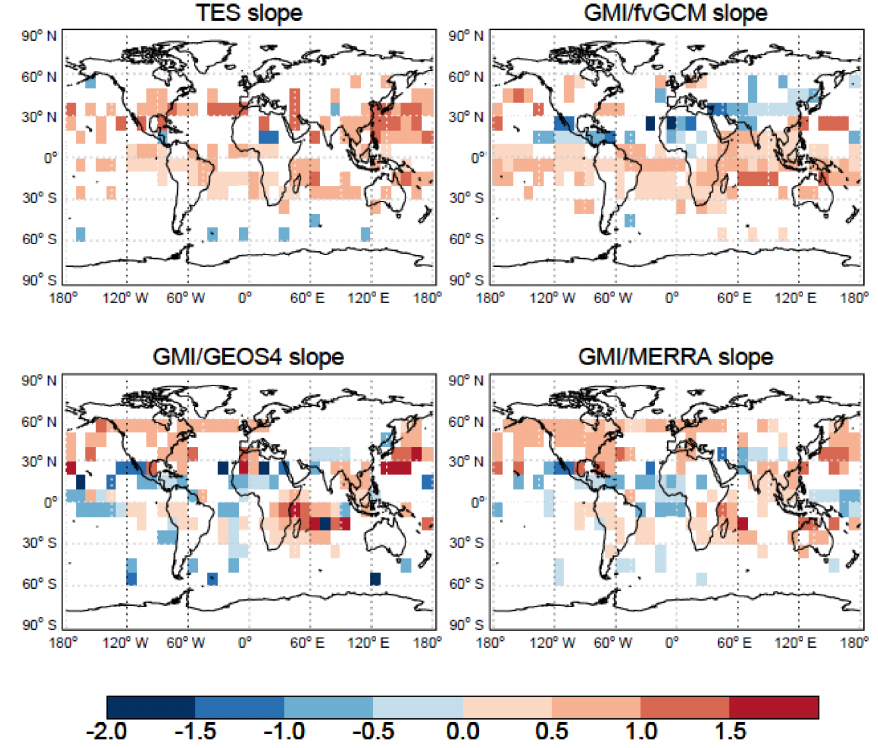
Figure 14. Same as Fig. 13 but for linear regression slopes dO 3 / dCO.